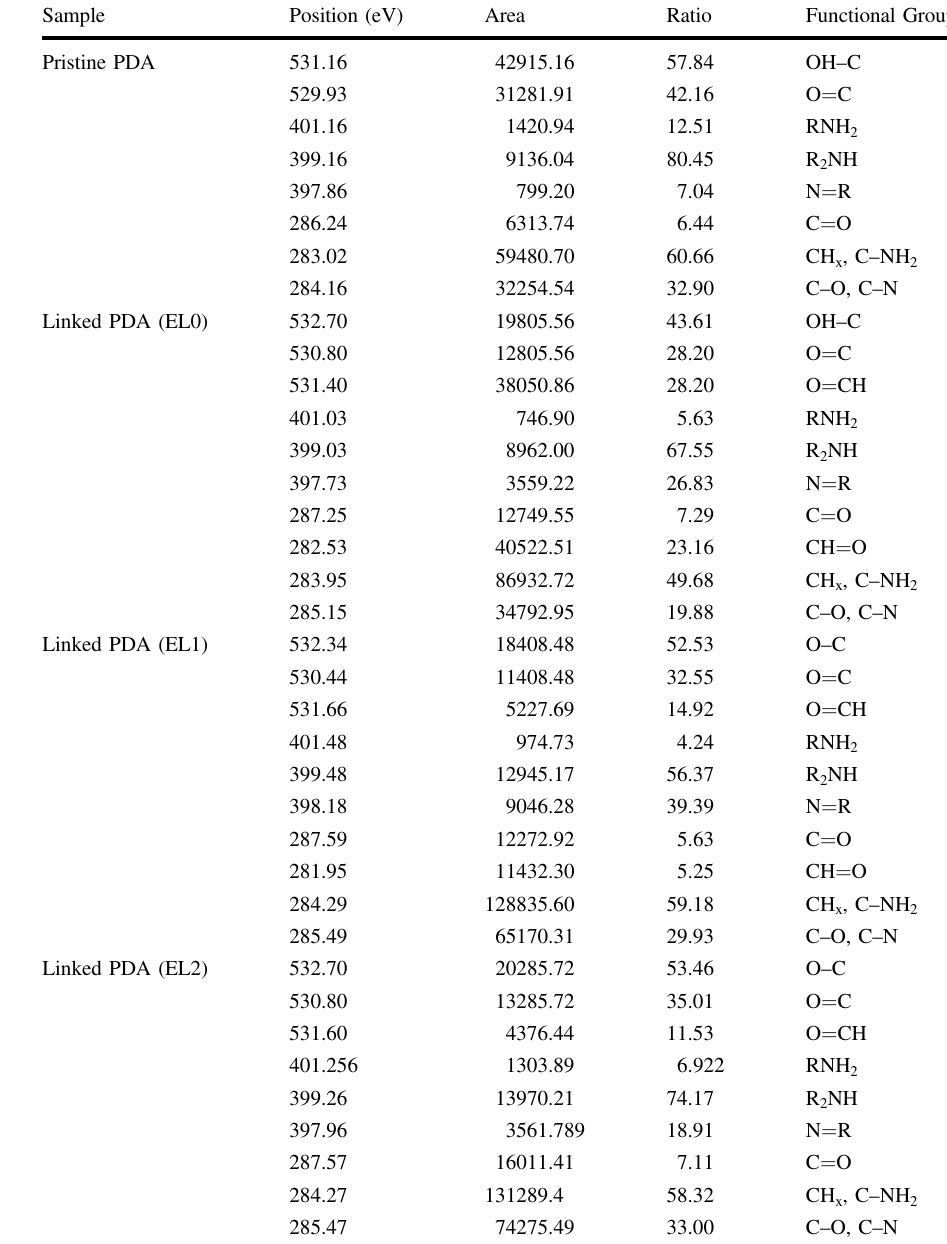
Sample Position (eV)